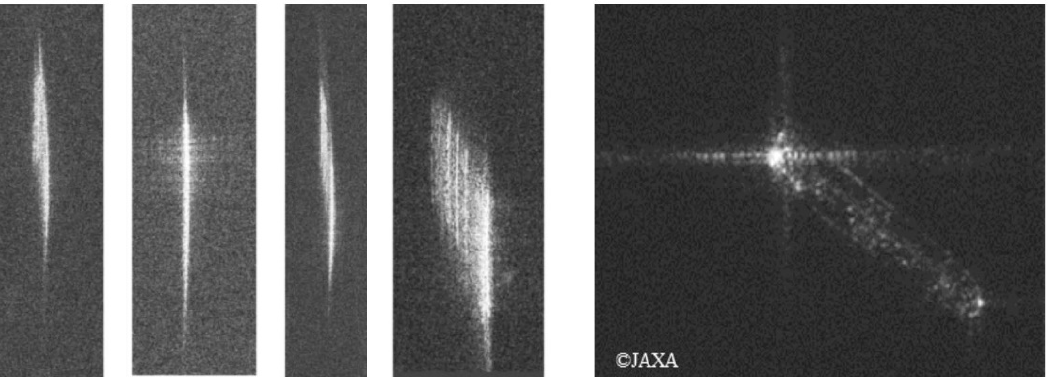
Figure 2. Left : Examples of 4 defocused and azimuth-extended images of cruising ships due to long integration times extracted from Figure 1. Right : Focused image of a stationary ship. The directions are the same as those in Figure 1.